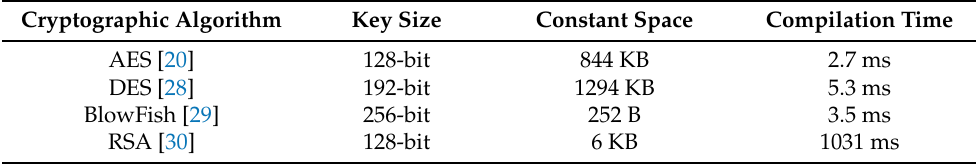
Table 4. Memory size, line of code for cryptographic algorithm implementation using OpenCL [27].